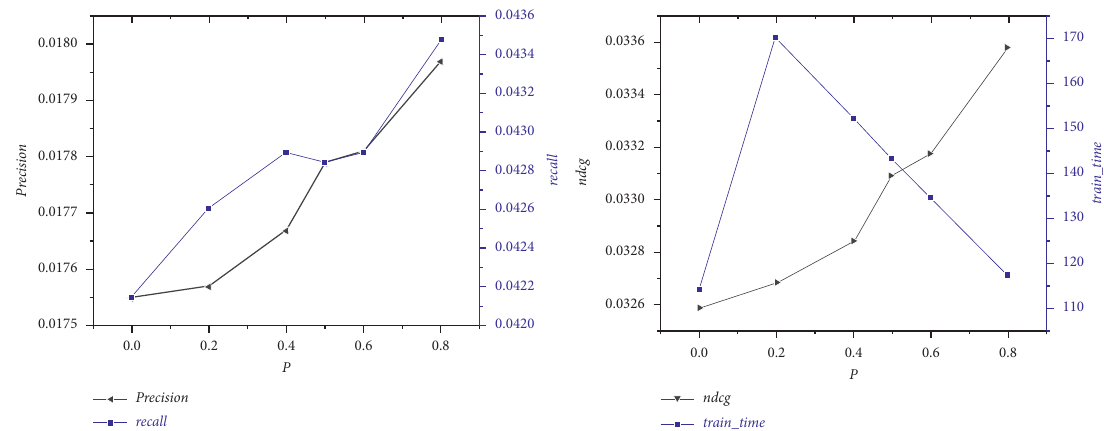
Figure 7: Algorithm performance under different edge drop rates